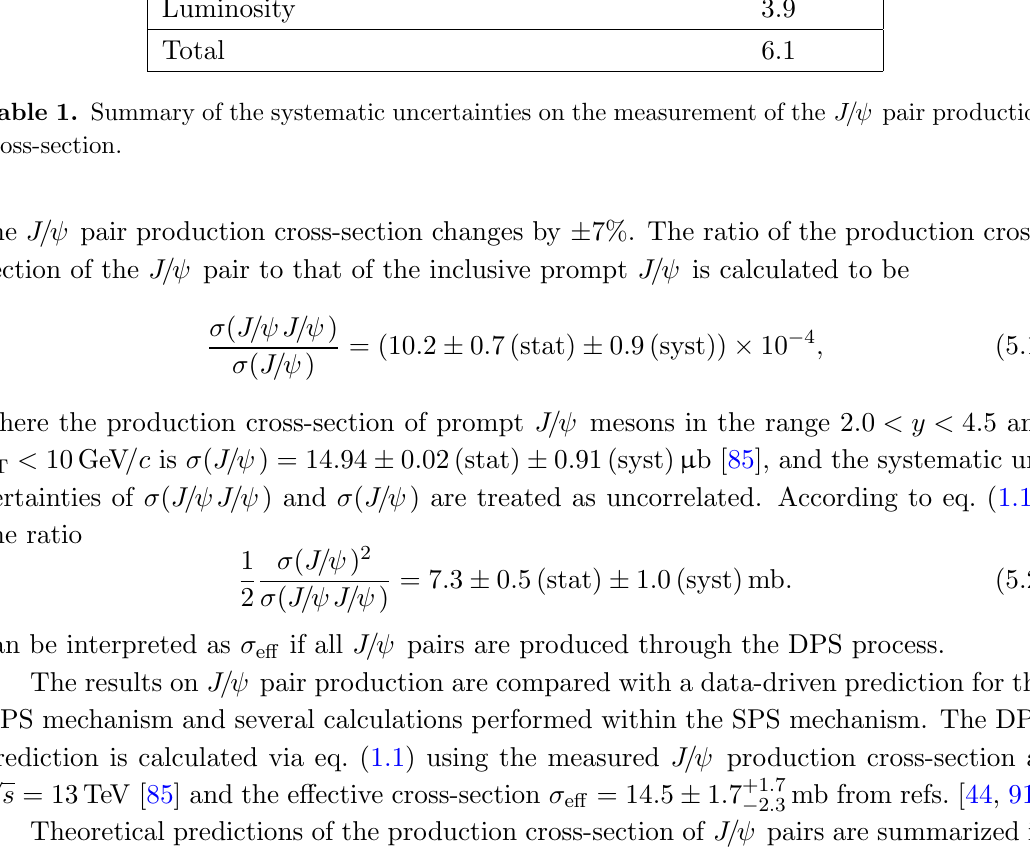
table 2. The contribution from the SPS mechanism is calculated using several approaches: the state-of-art complete NLO colour-singlet (NLO CS) computations [39]; the incom- plete (no-loops) next-to-leading-order colour-singlet (NLO (cid:3) CS) calculations [70, 92{96]; leading-order colour-singlet (LO CS) [92] and colour-octet (LO CO) [95, 96] calculations and the approach based on the k T -factorisation method [97{101], with the leading-order colour-singlet matrix element (LO k T ) [102, 103]. Even with the leading-order matrix el- ement, the LO k T approach includes a large fraction of higher-order contributions via the evolution of parton densities